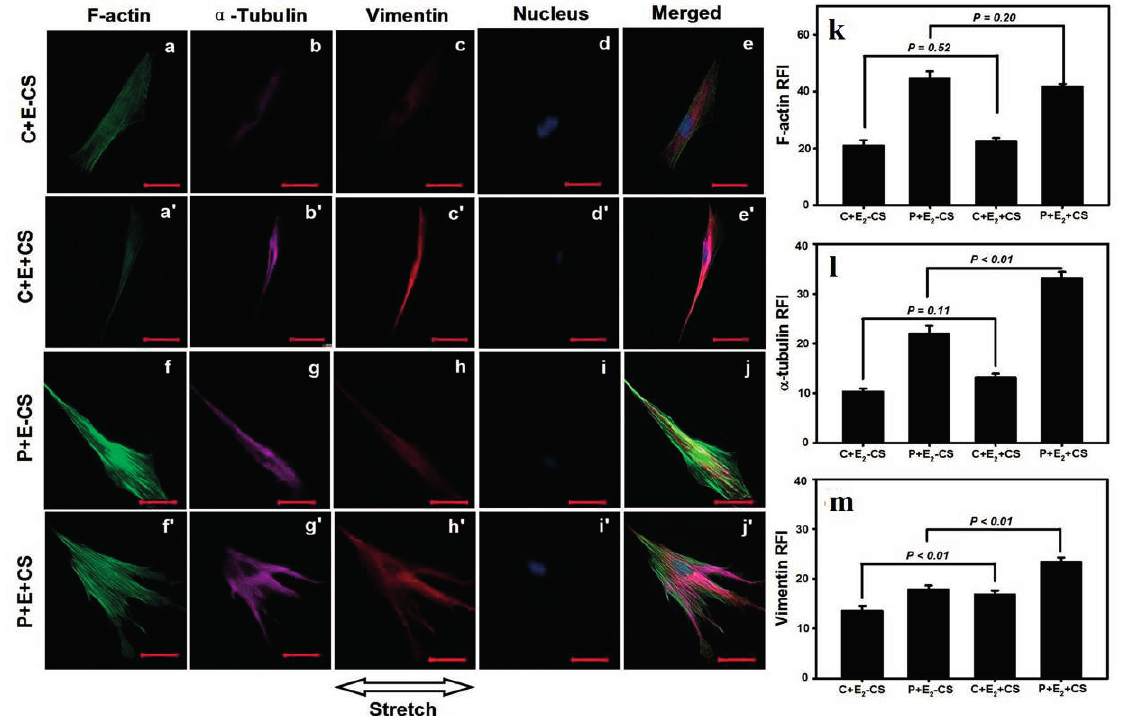
Figure 5. Effects of CS and E 2 on vaginal fibroblast cytoskeletons. The comparisons in RFIs of the cytoskeletal proteins between the fibroblasts cultured in static conditions with E 2 and cultured in the presence of CS concomitant E 2 ( k – m ). Images of the cytoskeletons ( a' – e' and a – e , f' – j' and f – j ). Bar = 50 μ m. The RFIs of F-actin ( k ), α -tubulin ( l ), and vimentin ( m ) were measured and are represented as the mean ± SE from triplicate